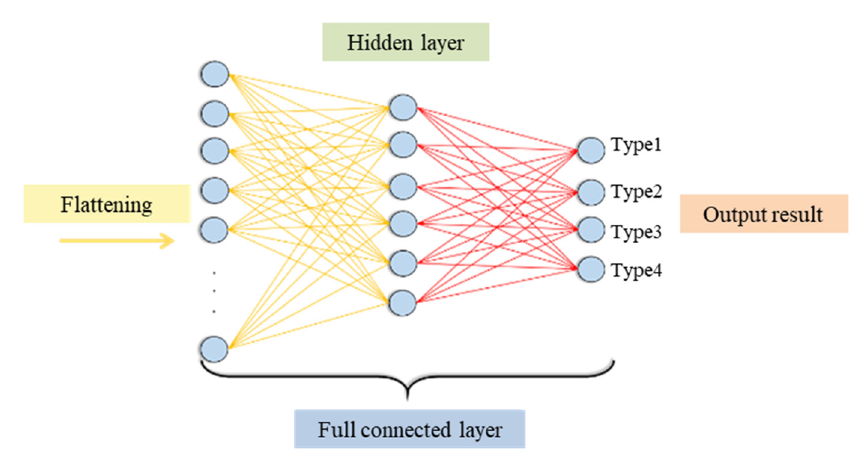
Figure 15. Computing architecture of the fully connected layer